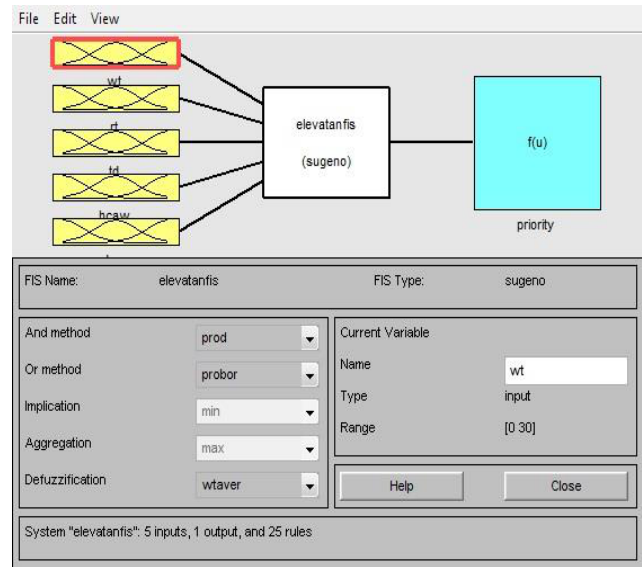
Figure 3. Fuzzy system for